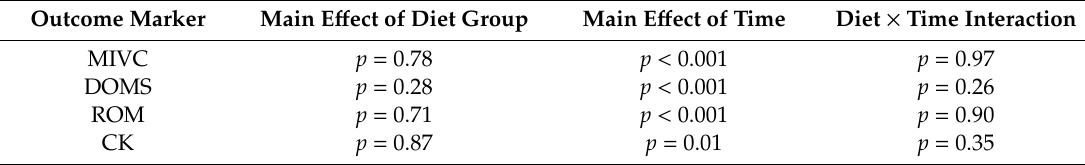
Table 2. Analysis of outcome markers with hyper-responders